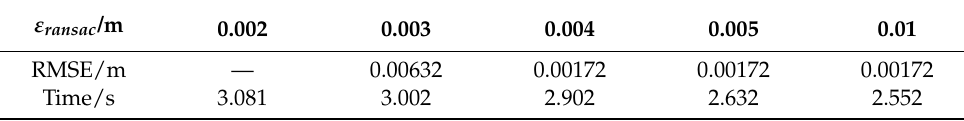
Table 3. Registration errors under different values of ε ransac .